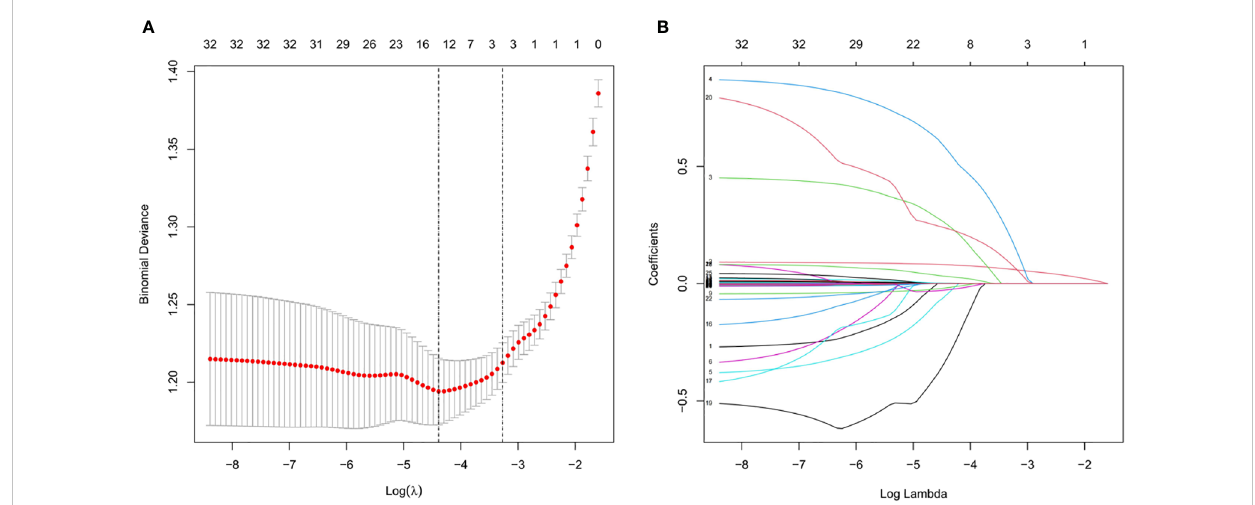
FIGURE 2 Clinical index selection using LASSO regression analysis. (A) Log(lambda) and partial likelihood deviations are shown, and the dotted line shown at the smallest log(lambda) represents the best predictor. (B) LASSO coef fi cients for the 32 clinical indicators. Non-zero coef fi cients were determined based on the best logarithm